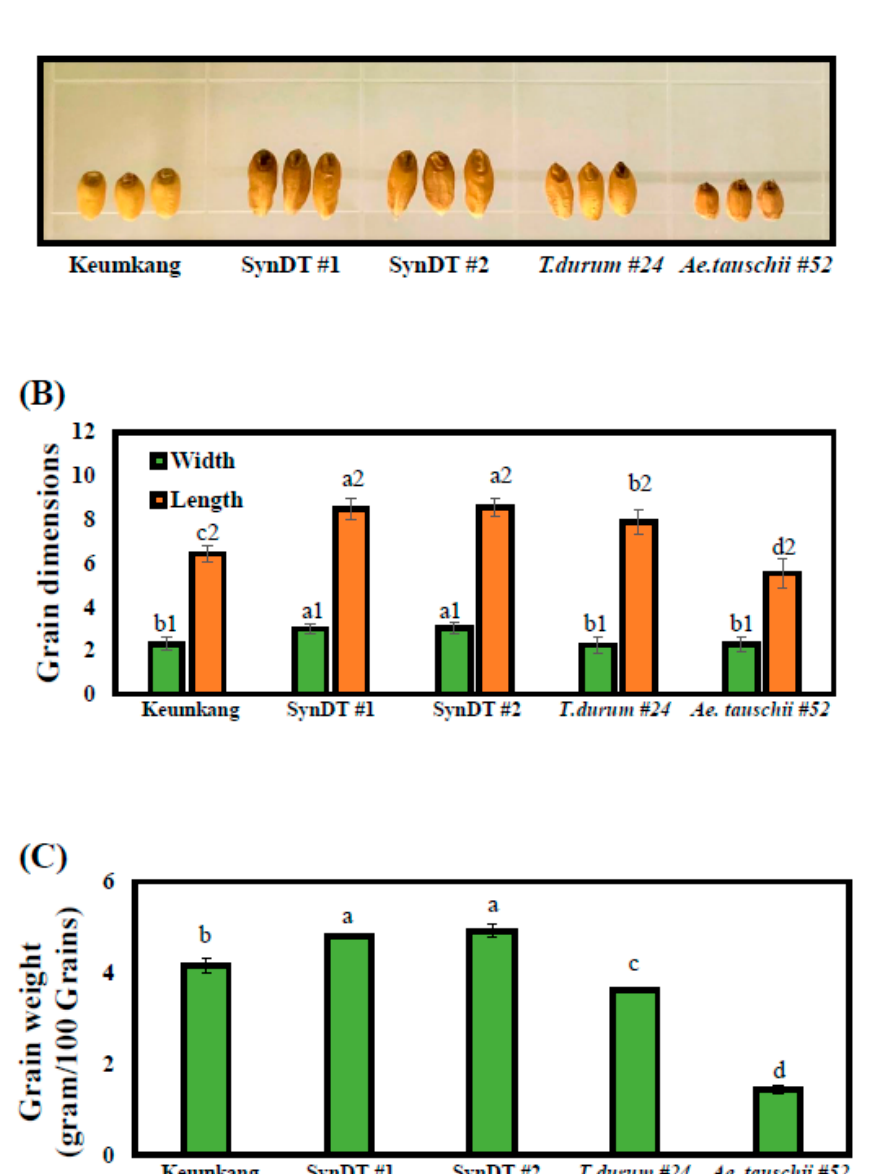
Figure 2. Grain morphology of all studied wheat cultivars. ( A ) Pictures of grain morphology of Keumkang, SynDT #1 and #2, T. durum #24 , and Ae. tauschii #52 . ( B ) Grain dimensions of Keumkang, SynDT #1 and #2, T. durum #24 , and Ae. tauschii #52 . ( C ) Weight of 100 grains of Keumkang, SynDT #1 and #2, T. durum #24 , and Ae. tauschii #52 . Standard deviation value was calculated from three replicates in each treatment. One-way ANOVA and Tukey’s test ( α = 0.05) were performed using Statistical Analysis System (SAS). Different letters (a, b, or c) indicate significant differences ( p <